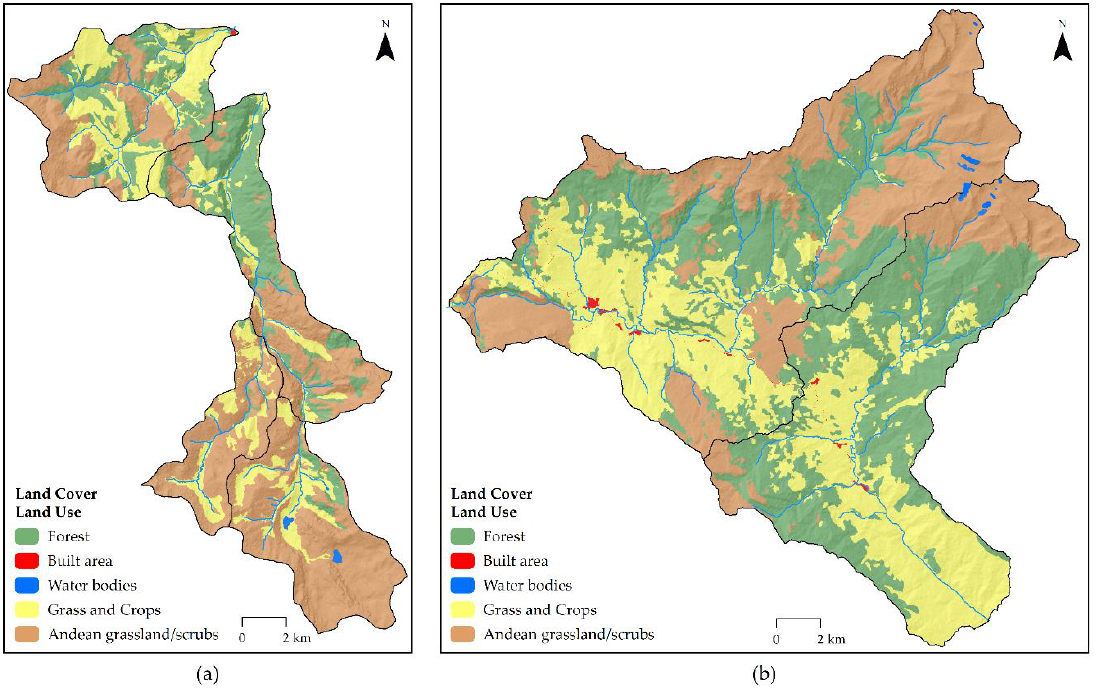
Figure 6. Land Cover / Land Use (LC / LU) of the ( a ) four HAL-MWs in Leimebamba and ( b ) two HAL-MWs in Molinopampa (Amazonas, Peru), in 2017. Table 11. Land Cover/Land Use (LC/LU) of the four HAL-MWs in Leimebamba and two HAL-MWs in Molinopampa (Amazonas, Peru).